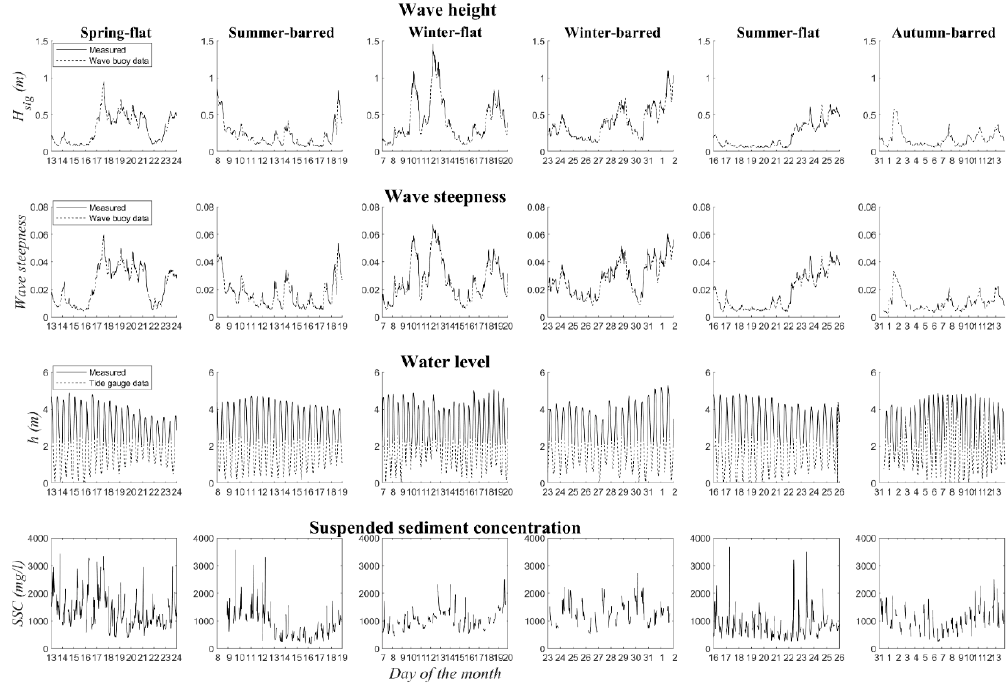
Figure 3. The 30-min-averaged hydrodynamics: significant wave height ( H sig ), wave steepness, and water level ( h ), and suspended sediment concentration (SSC) for all the campaigns. The measured water level is supplemented with tide gauge data from Oostende Harbor for low tide (dashed lines). Table 2. Overview of the hydrodynamic conditions and SSC for all campaigns. Spring—Flat Summer—Barred Winter—Flat